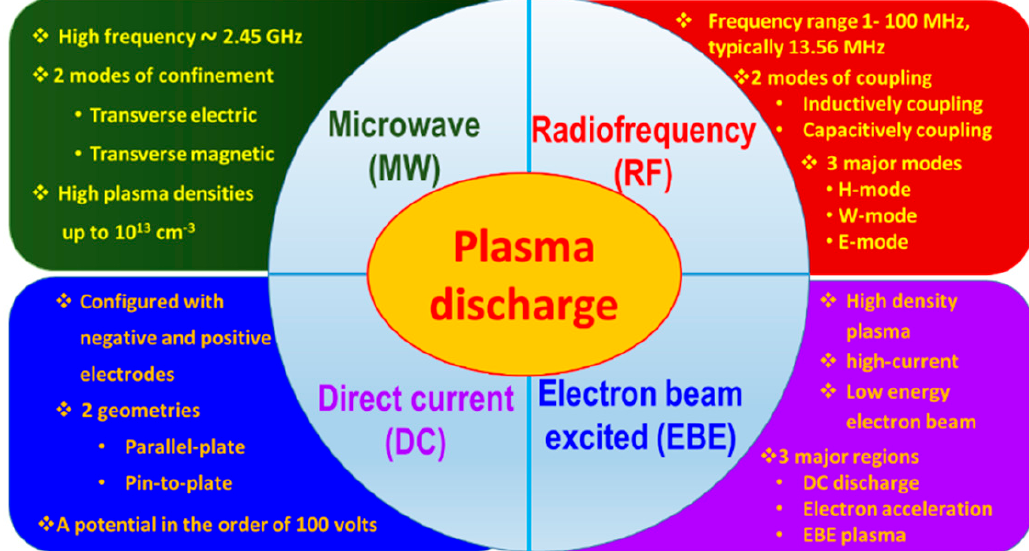
Figure 2. Different plasma systems for the carbon nanowall (CNW) growth.